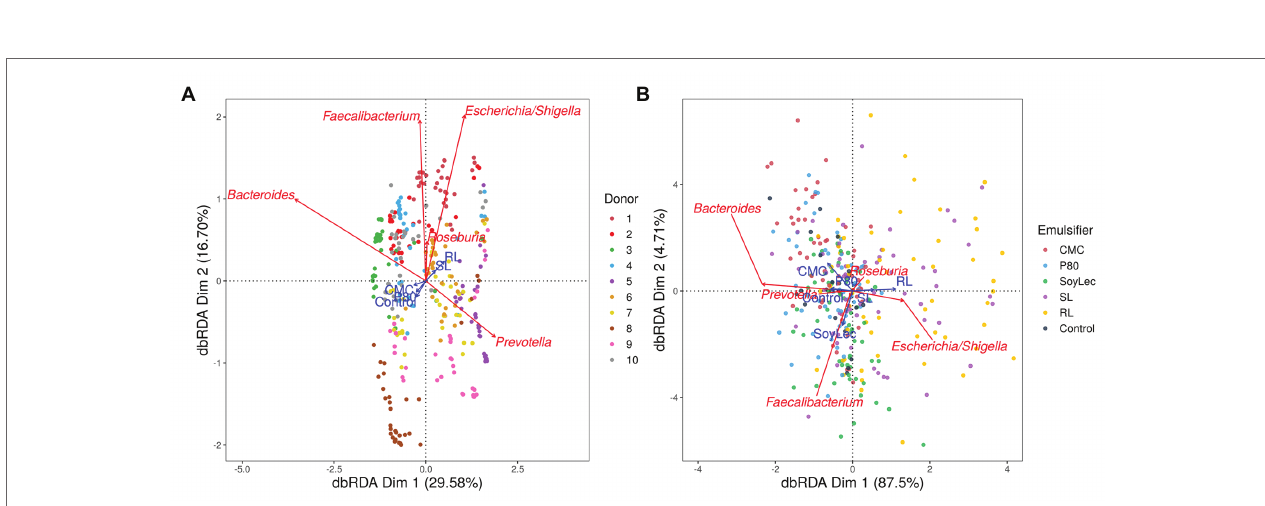
FIGURE 2 | Average total (A) and intact (B) bacterial cell counts (cells/ml) detected during in vitro batch incubations of fecal material from 10 donors with sugar depleted medium supplemented with five emulsifiers at four concentrations. Samples were taken upon incubation (T0; 2-3 h after inoculation) as well as after 24 h (T1) and 48 h (T2) of incubation. Asterisks indicate significant differences detected with a Kruskal–Wallis test ( α = 0.05).